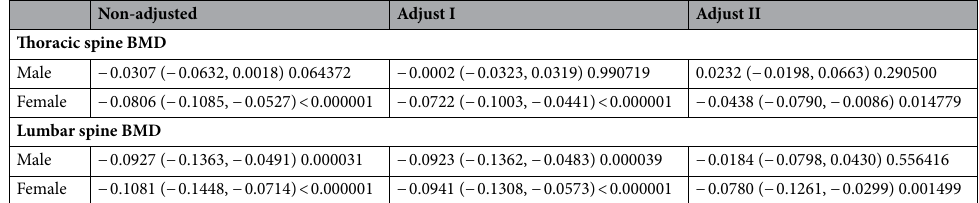
Table 3. Association between HGB and BMD stratified by gender. Expose variable HGB (g/dL), ending variable lumbar spine BMD, the results in the table are expressed as β (95% CI). Model 1, no covariates were adjusted. Model 2, age, race were adjusted. Model 3, age, race, annual household income, education level, SBP, DBP, BMI, red blood cell count, albumin, ALP, ALT, blood urea nitrogen, total calcium, iron, CPK, creatinine, glucose, LDH, phosphorus, total bilirubin, total protein, uric acid, albumin creatinine ratio, blood cadmium, blood lead, phosphorus, potassium, triglyceride, LDL-C, HDL-C, total cholesterol, alcohol status, smoking status and diabetes were adjusted. In the subgroup analysis stratified by gender, the model is not adjusted for the stratification variable itself.